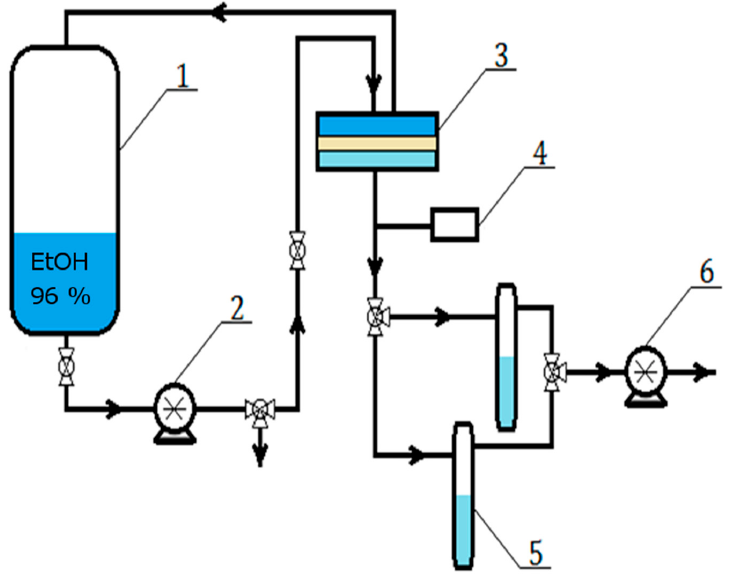
Figure 1. Scheme of the pervaporation setup: 1—feed tank, 2—circulation pump, 3—separation chamber, 4—vacuum gauge, 5—cooled collection traps, and 6—vacuum pump.